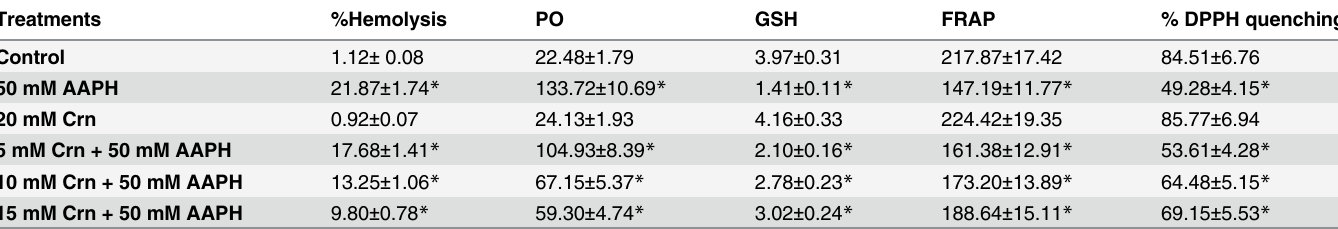
Table 2. Effect of creatinine on AAPH-induced changes in some erythrocyte parameters.